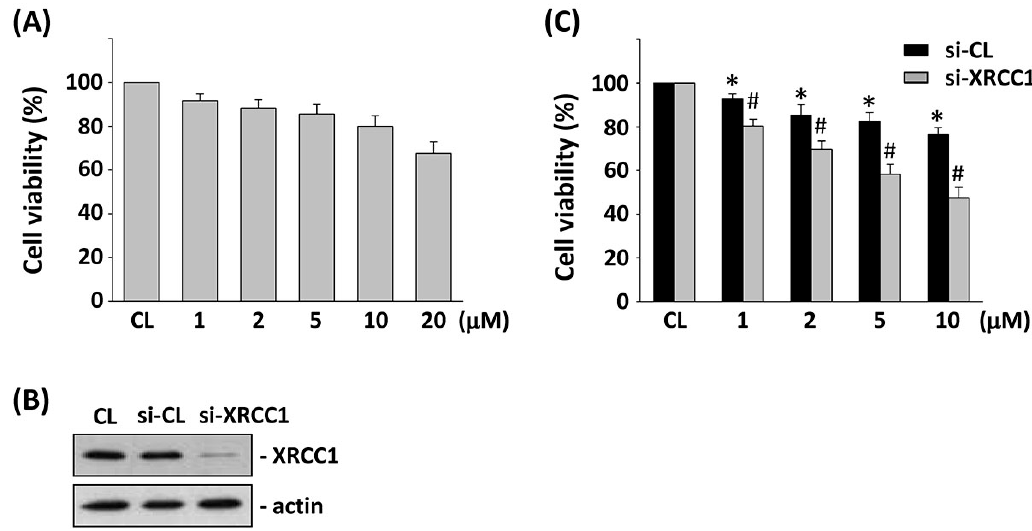
Figure 2. Effects of XRCC1 on 5-FU-induced cytotoxicity in HCT-116 cells. ( A ) HCT-116 cells were kept as controls (CL) or stimulated with different doses of 5-FU for 24 h; cell viability was assayed by the 3-(4,5-dimethylthiazol-2-yl)-2,5-diphenyltetrazolium bromide (MTT) analysis. ( B ) Cells were transfected with control siRNA (si-CL), or a specific siRNA of XRCC1, and then stimulated with different doses of 5-FU for 24 h. Cell viability was assayed by the MTT test. The results are shown as mean ± SEM. * p < 0.05 versus CL. # p < 0.05 versus si-CL-treated cells with 5-FU treatment. ( C ) The gene silencing efficiency of 48 h transfection of siRNA on XRCC1 levels of HCT-116 cells was isolated and Western blotting was used to analyze the XRCC1 expression.